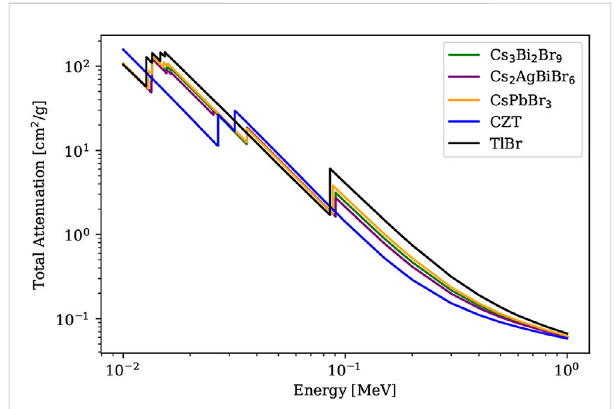
FIGURE 1 Energy-dependent total attenuation cross-section of Cs 3 Bi 2 Br 9 along with contemporary inorganic perovskites and semiconductor detector materials (XCOM data).